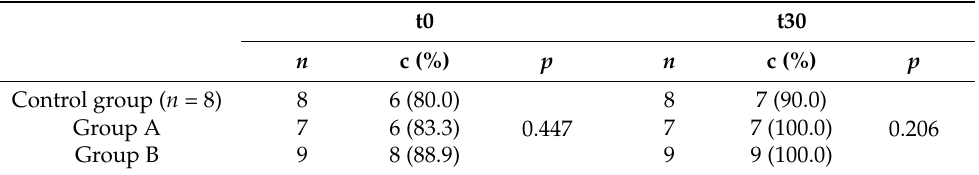
Table 5. Distribution of adult women subjected to cryolipolysis on one (A) or multiple areas of the body (B) according to presence of inflammation (C-reactive protein > 1.0 mg/dL). t0